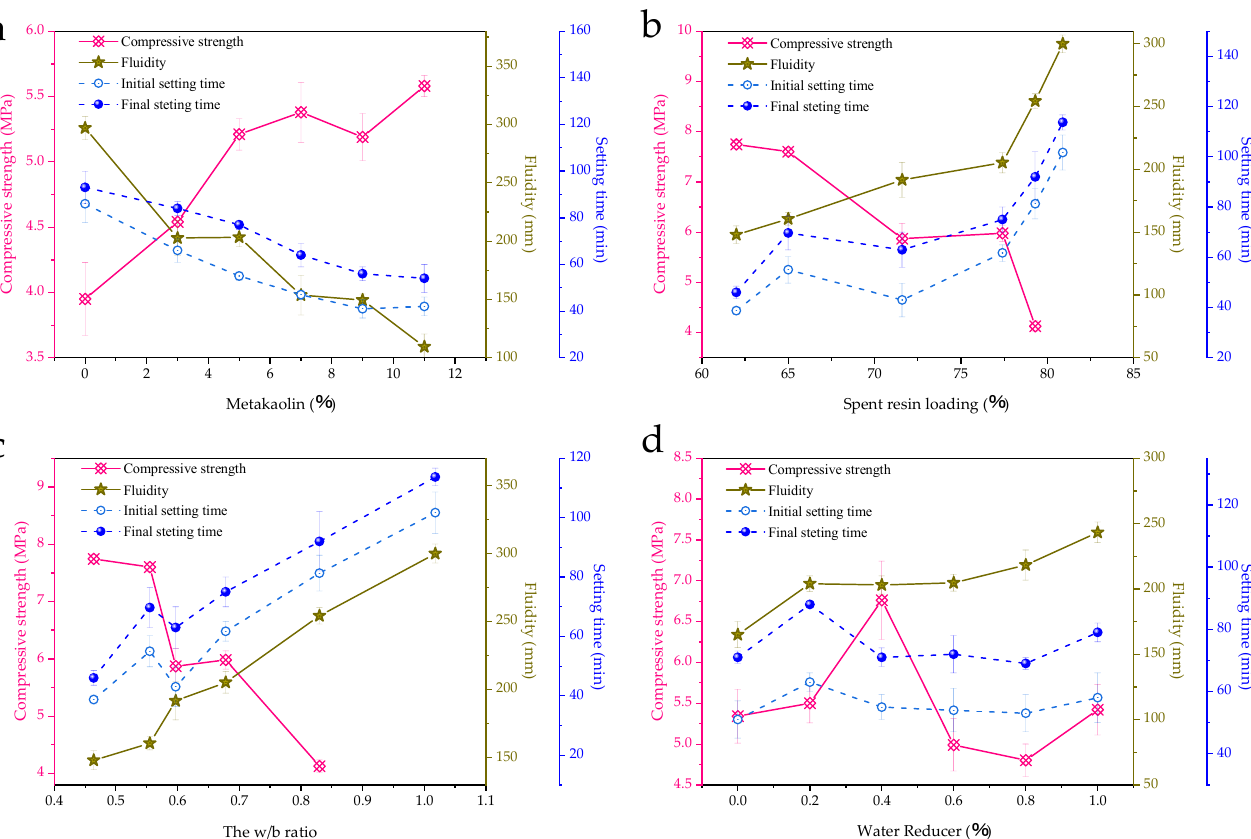
Figure 1. Solidification performance affected by ( a ) metakaolin (spent resin loading 77.4%, w/b ratio 0.68, water reducer 0.4%), ( b ) resin loading (metakaolin 5%, water reducer 0.6%~0.7%), ( c ) w/b ratio (metakaolin 5%, water reducer 0.6%~0.7%), and ( d ) water reducer (metakaolin 5%, spent resin loading 77.4%, w/b ratio 0.68).